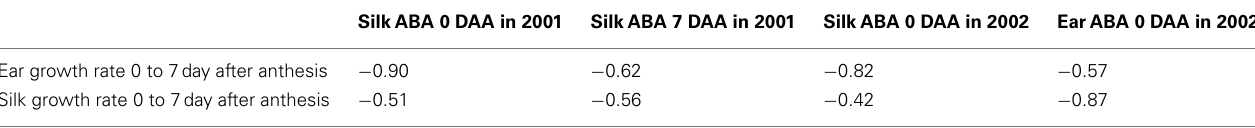
Table 1 | Genotypic correlations betweenABA levels and growth rates in ears and silks in a recombinant inbred line (RIL) population (Cimmyt P1 X P2) in two trials (2001 and 2002) under severe water deficit at flowering at theTlaltizapan, Mexico field